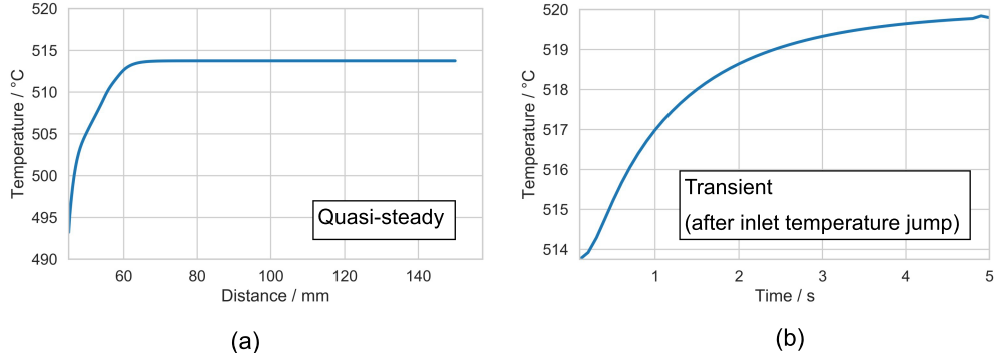
Figure 5. Simulation results for the temperature at the location of the thermocouple junction. ( a ) Quasi-steady temperature distribution along the thermocouple (from the outer wall of the autoclave head to 25 mm beyond the tip of the thermocouple), ( b ) Temperature change at the thermocouple junction after a jump in temperature of the in-flowing fluid (time scale ranges from temperature jump to the re-establishing of a quasi-steady state).